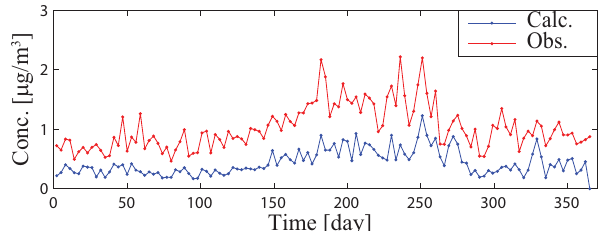
Fig. 7. Daily mean values of the simulated OA concentrations against observations from the IMPROVE network, taken as an av- erage over the sites shown in Fig.